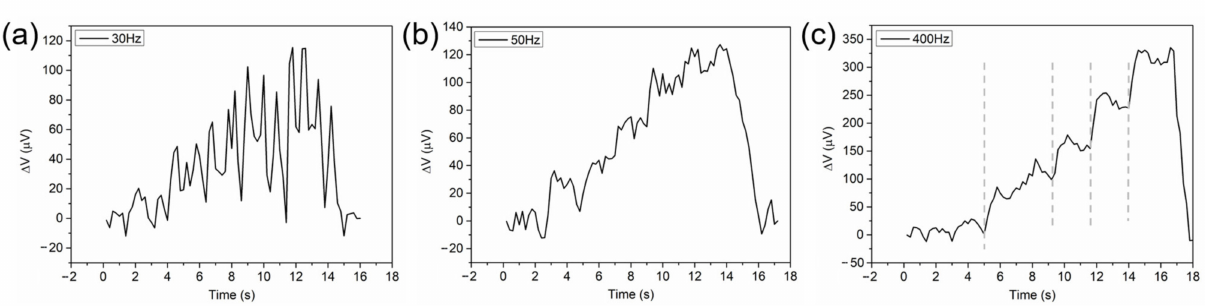
Figure 3. The output voltage curve versus peak value at different pulse frequencies: ( a ) 30 Hz, ( b ) 50 Hz, and ( c ) 400 Hz. The dashed gray lines represent the moments when the power of the laser is